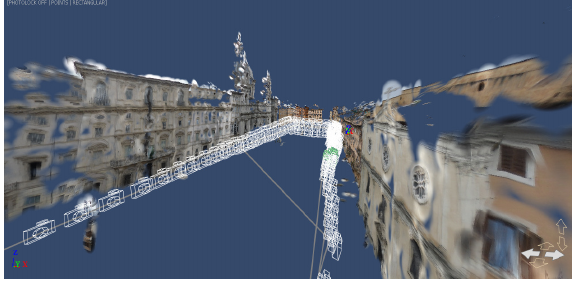
Figure 3. Navona Square, Rome, Manual Reconstruction